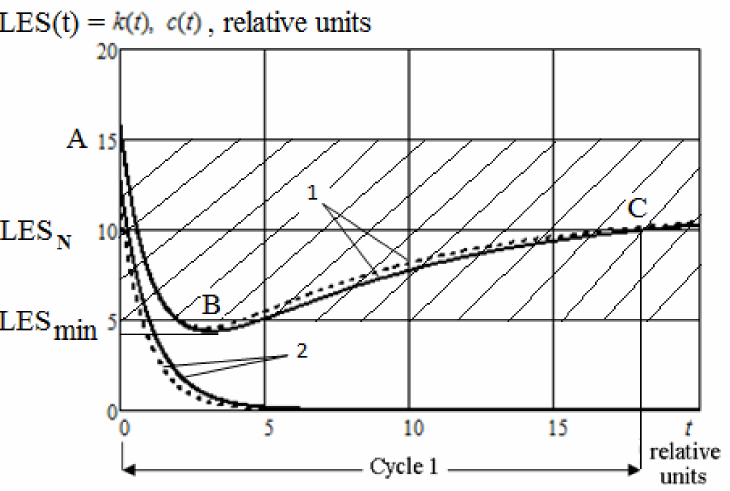
Figure 4. Estimated dynamics of the levels of sustainability and efficiency of the processes of combining resources and organization in the formation cycle of a multipurpose energy technology complex: LES: level of economic sustainability; A is maximum property index; B is minimum property index; C is property indicator